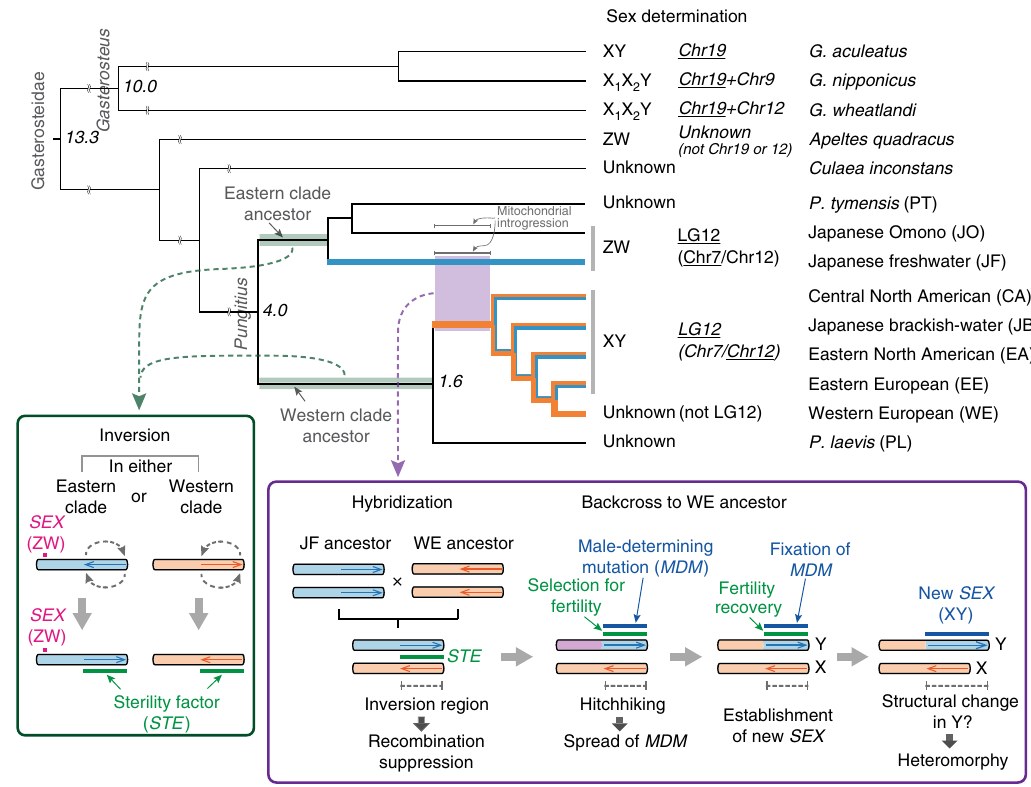
Fig. 6 Evolution of sex determination in Gasterosteidae fi shes. Hypothetical processes involved in the evolution of the XY sex determination system in the Pungitius genus are shown in the boxes. The green shading on the Eastern and Western clades indicates the evolution of the inversion and sterility factor. The blue and orange colors in the phylogenetic tree represent different chromosomal origins of the inversion region. The branch leading to the P. pungitius lineages in the Western clade is indicated in orange to represent the ancestral condition prior to the hybridization event shown in the purple box. Phylogeny and sex determination are based on this and earlier studies 15, 21, 22, 47, 70 . Sex-determining chromosomes are underlined, and heteromorphic sex chromosomes are indicated in italic. Divergence times based on fossil records 70 and mitochondrial divergence are shown in italics (in millions of